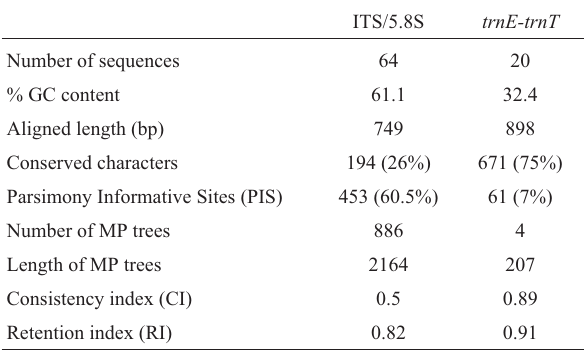
Table 2 - Sequence alignment information and summary of the maximum parsimony (MP)